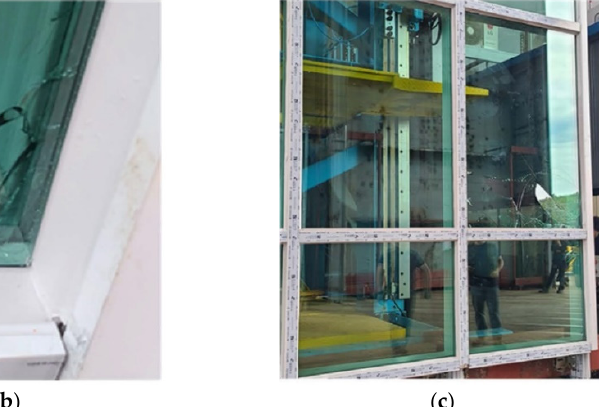
Figure 12. Dynamic seismic waveform applied to the AAMA 501.6 test method. Table 6. Dynamic racking crescendo test results.